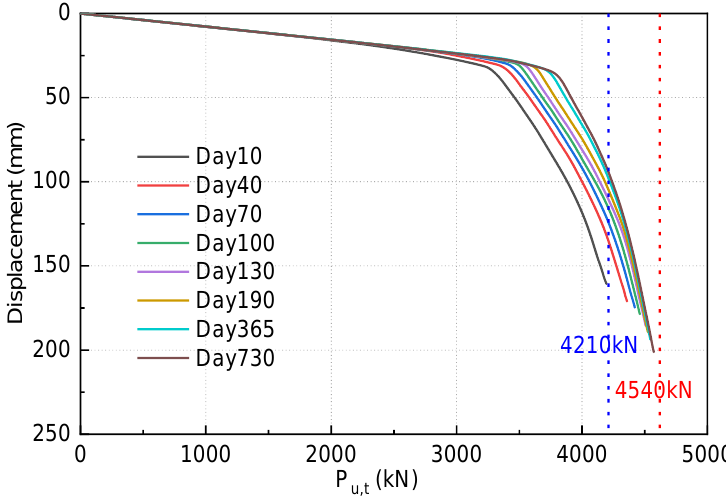
Figure 6. Simulation result of axial compressive test under different consolidation degrees.